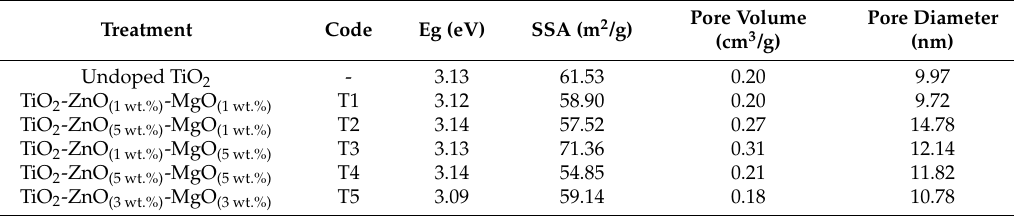
Table 2. Band gap energy (Eg) values and textural properties of pure TiO 2 and mixed oxide (TiO 2 -ZnO-MgO)